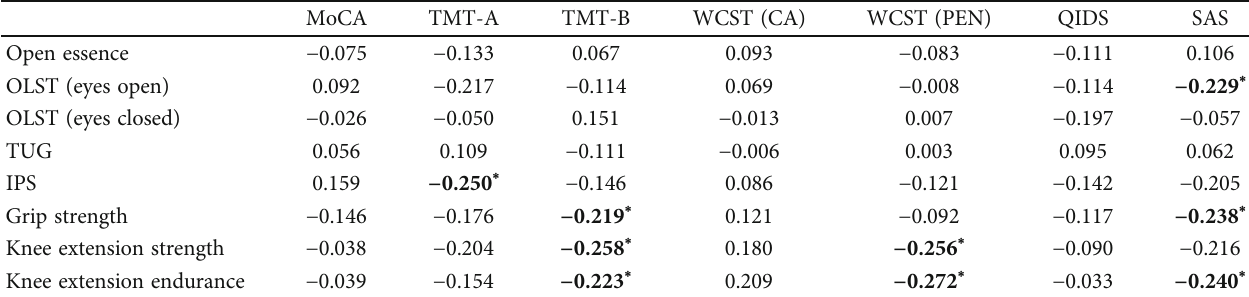
Table 5: Correlation between cognitive function test, olfactory identi fi cation test, balance capability tests, and muscle strength tests in the control group.